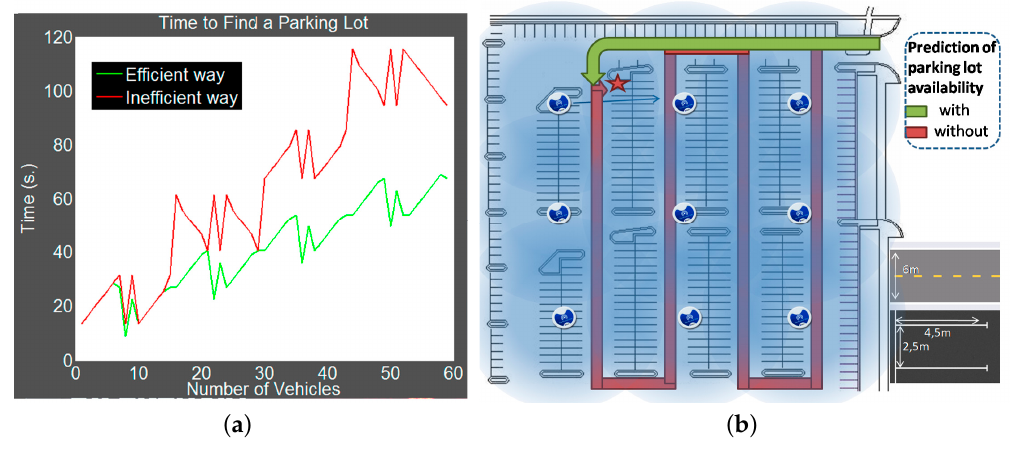
Figure 10. Example of times to find an available parking space. ( a ) chart; ( b ) simulated